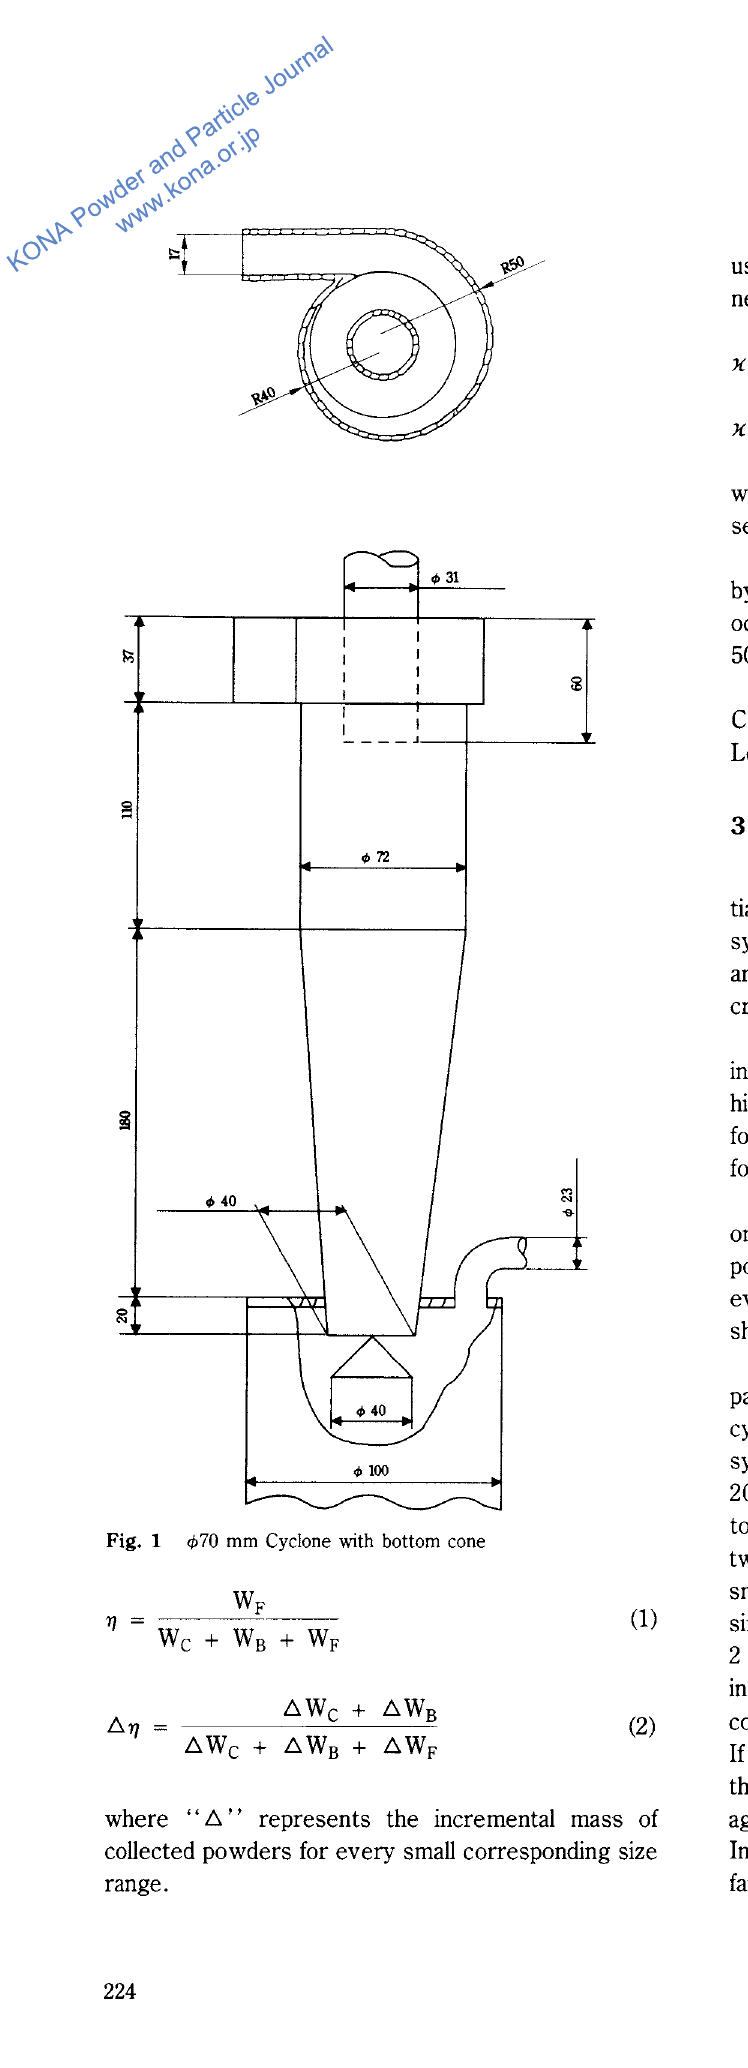
where '' /:::,. '' represents the incremental mass of collected powders for every small corresponding size